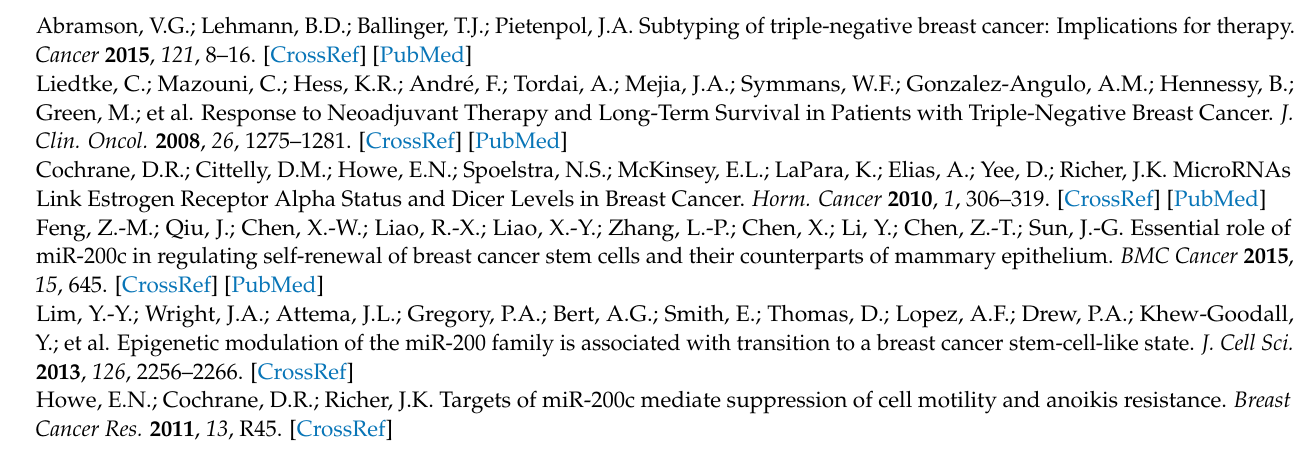
morphology using additional cell lines/shRNA constructs. (C) Mitochondrial number (top) and mitochondrial interconnectivity (bottom), based on quantification of confocal microscopy by imagej. Figure S8: (A) Western blot of various fission/fusion proteins in NPC1+/ − cells under various metabolic and lysosome stressors (24 h treatment. BafA1 5nM). (B) Western blot of p4EBP1 branch of mTOR signaling under metabolic and lysosome stress. (C) Dose Response curve of U18666A in MCF7 cells, viability relative to DMSO control over 48 hours, analyzed with Crystal Violet. (D) Lowe synergy score of U18666A ( µ M) and Paclitaxel (nM) in BT549 at 48 h. Calculated using SynergyFinder 2.0. Table S1: Luciferase Assay Sequences. Table S2: qPCR